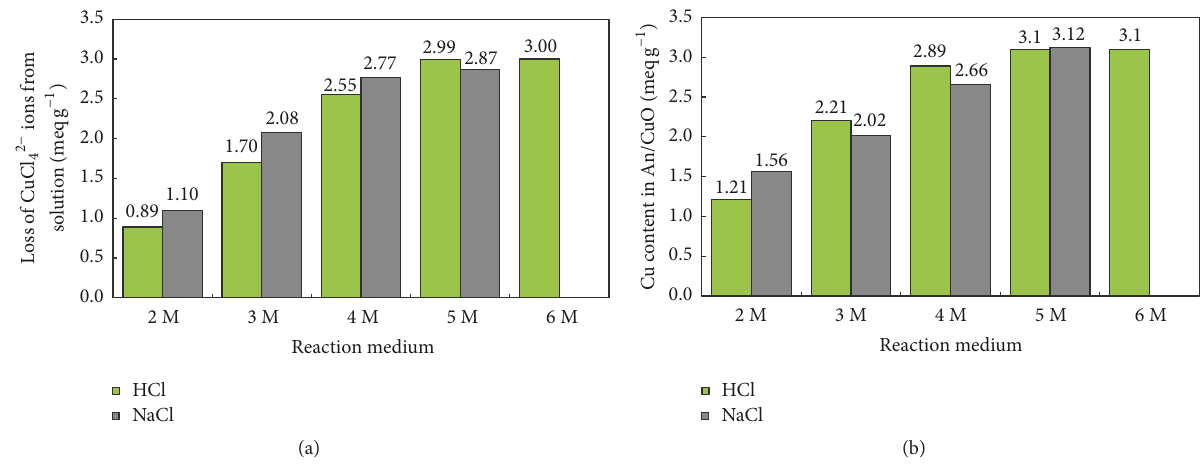
Figure 1: (a) Loss of CuCl 42− ions from the solutions in batch reaction at ambient temperature (1.0g An/Cl − in 10 cm 3 of 0.5 mol dm −3 CuCl 2 in different media) and (b) Cu content in corresponded HIX.